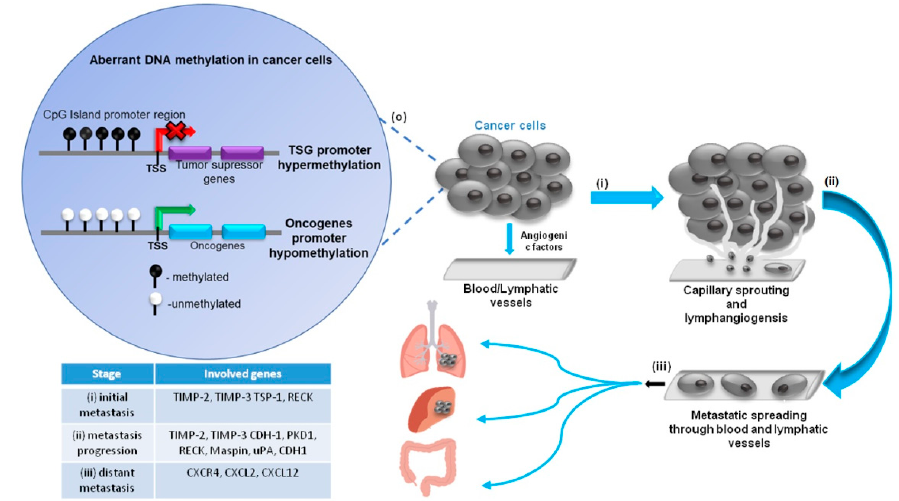
Figure 1. Potential gene targets for anticancer therapy in DNA methylation-guided cancer progression and metastasis. ( o ) Tumor formation as a consequence of aberrant DNA methylation in oncogenes and tumor-suppressor genes and further steps of cancer progression: ( i ) initial metastasis-tumor growth and stimulation of capillary formation, invasion; ( ii ) metastasis progression-intravasation, invasion of cancer cells through the basal membrane into a blood or lymphatic vessel; ( iii ) distant metastasis-extravasation, spreading of cancer cells to nearby lymph nodes, tissues, or organs and formation of distant tumors.